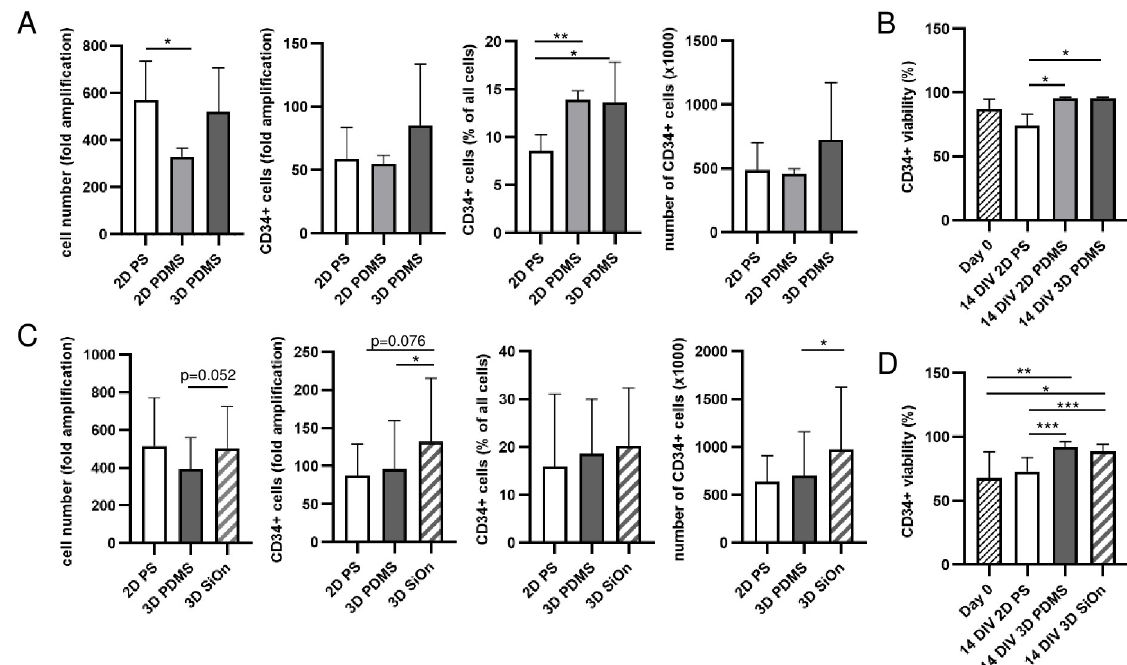
Fig 3. Effects of 2D and 3D polydimethylsiloxane (PDMS) structures on human HSC cultivation. Human HSCs were cultured for 14 DIV in HSC medium supplemented with 1 mM VPA on SiOn-covered and uncovered 2D PDMS or 3D PDMS scaffolds. CD34+ cells were determined by flow cytometric analyses using a combination of anti-CD34/anti-CD45 mouse monoclonal antibody and 7AAD. (A) The amplification of all cells and CD34+ cells, the percentage and absolute number of CD34+ cells as well as their viability (B) are depicted for four different donors as their mean ± SD. (C) The amplification of all cells and CD34+ cells, the percentage and the absolute number of CD34+ cells as well as their viability (D) are depicted for nine different donors as their mean ± SD. � p < 0.05, �� p < 0.01, ��� p <